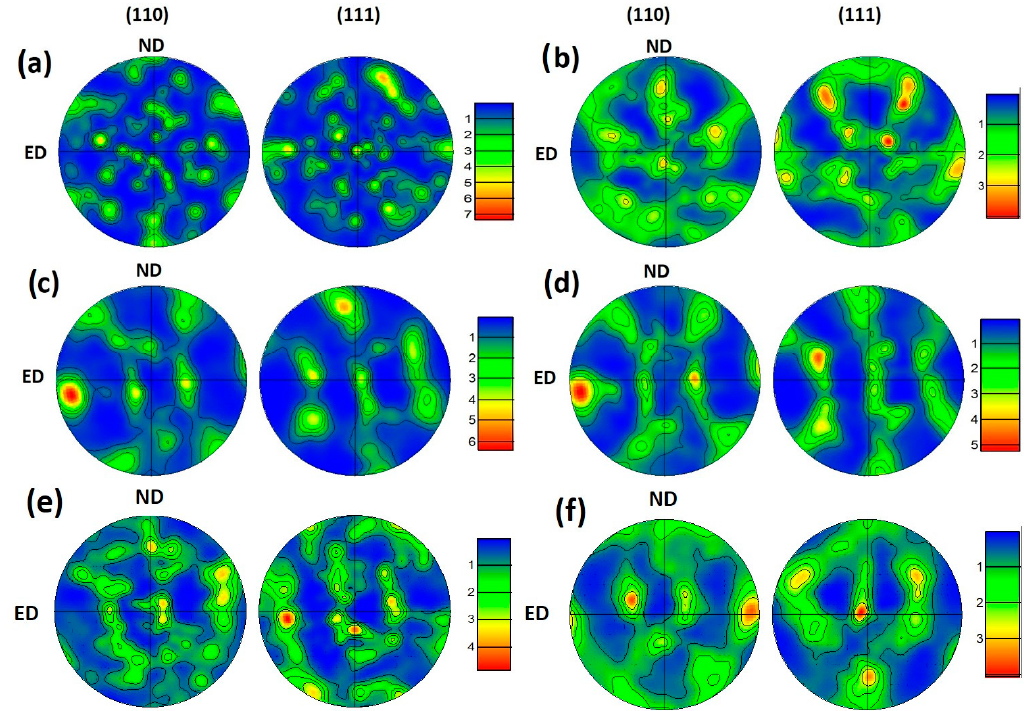
Figure 9. (110) and (111) pole figures of commercial pure Cu for the ( a ) AA, ( b ) 1-P_RT, ( c ) 2-Bc_RT, ( d ) 4-Bc_RT, ( e ) 1-P_200 °C and ( f ) 4-Bc_200 °C samples (for interpretation of the references to color in this figure legend, the reader is referred to the web version of the article). Table 2. Partial fibers and ideal components of simple shear texture in fcc metals